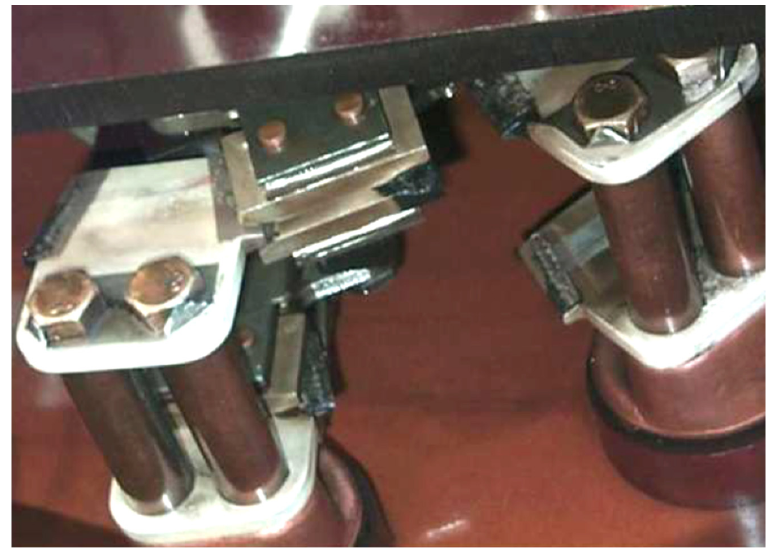
Figure 6. Burned contacts on stationary and movable contacts [14].